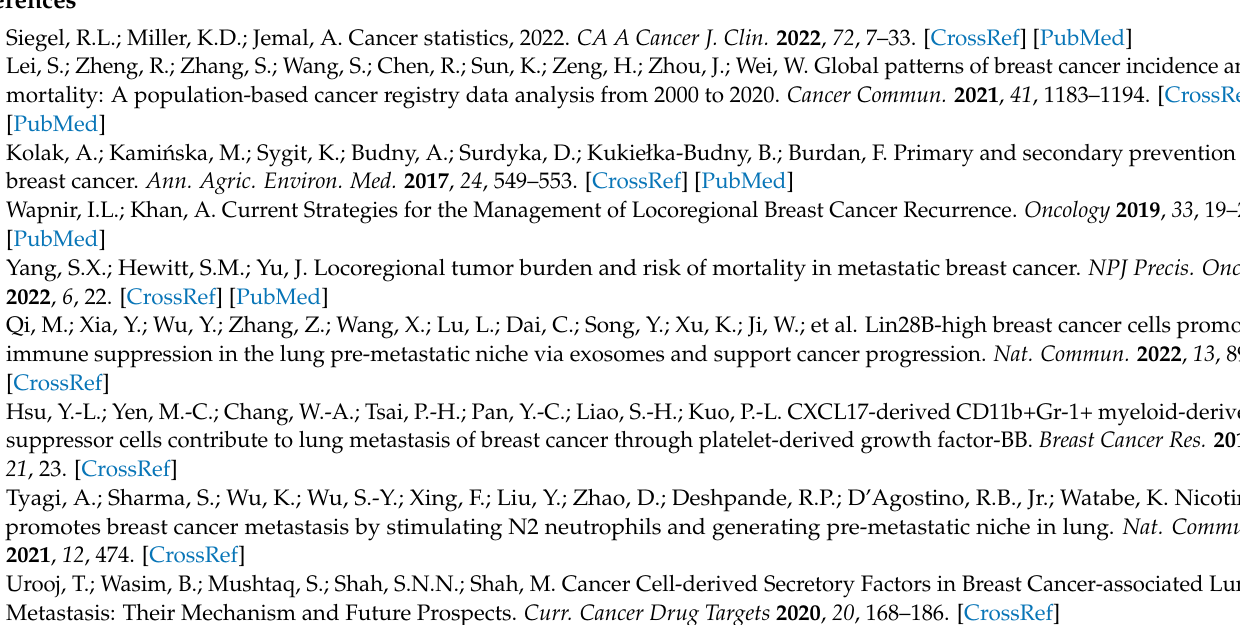
pathways of M4 module of N1- and N2-type neutrophils, Table S9: KEGG pathways of M5 module of N1- and N2-type neutrophils, Table S10: KEGG pathways of M7 module of N1- and N2-type neu- trophils, Table S11: KEGG pathways of M8 module of N1- and N2-type neutrophils, Table S12: KEGG pathways of M10 module of N1- and N2-type neutrophil, Table S13: Canonical pathways of lym- phatic ECs assessed by IPA, Table S14: WGCNA of ECs, Table S15: KEGG pathways of M1 module of lymphatic ECs, Table S16: KEGG pathways of M2 module of lymphatic ECs, Table S17: IPA anal- ysis of alv fibroblasts, Table S18: IPA analysis of adv fibroblasts, Table S19: WCGNA of fibroblasts, Table S20: KEGG pathways of M2 module of fibroblasts, Table S21: KEGG pathways of M3 module of fibroblasts, Table S22: KEGG pathways of M4 module of fibroblasts, Table S23: KEGG pathways of M5 module of fibroblasts, Table S24: Cell-cell interactions only in the lungs of MMTV-PyVT mice, Table S25: Elevated cell-cell interactions in the lungs of MMTV-PyVT mice, Table S26: Reduced cell-cell interactions in the lungs of MMTV-PyVT mice, Table S27: Loss of cell-cell interactions in the lungs of MMTV-PyVT mice, Table S28: The primers used in this study, Table S29: The antibodies used in